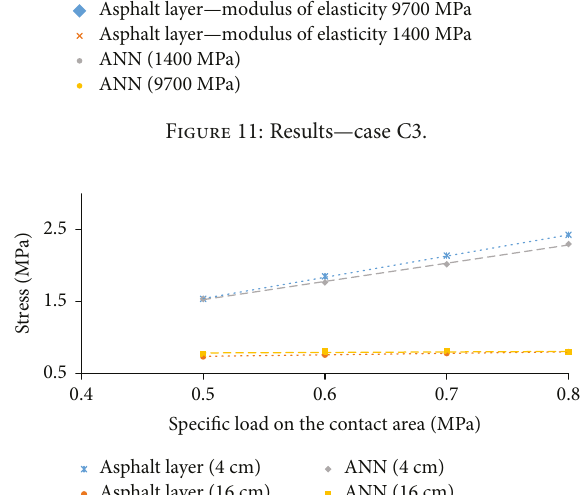
Figure 11: Results — case C3.